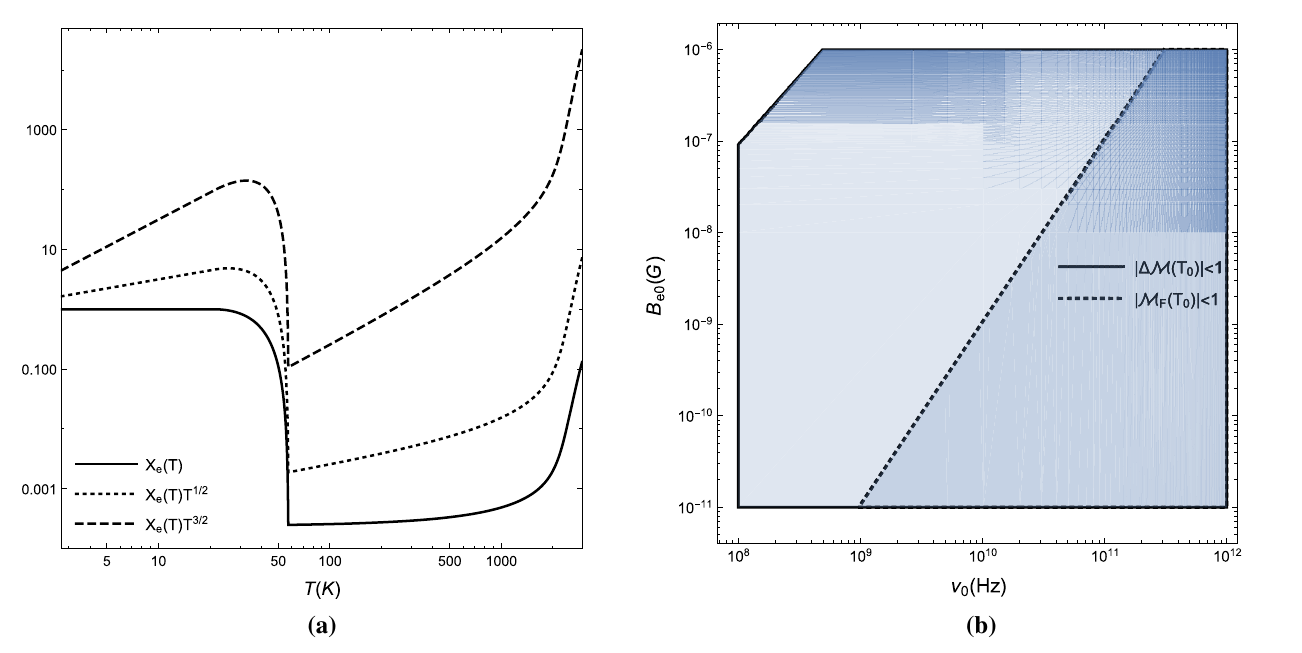
of ν 0 ∈ [ 10 8 , 10 12 ] (Hz) and B e 0 ∈ [ 10 − 11 , 10 − 6 ] (G) are shown. The region within the black line is the allowed region for stronger condition (31) of | (cid:23) M ( T 0 ) | < 1 while the region within the black dotted line is the allowed region for the stronger condition (30) of | M F ( T 0 ) | <